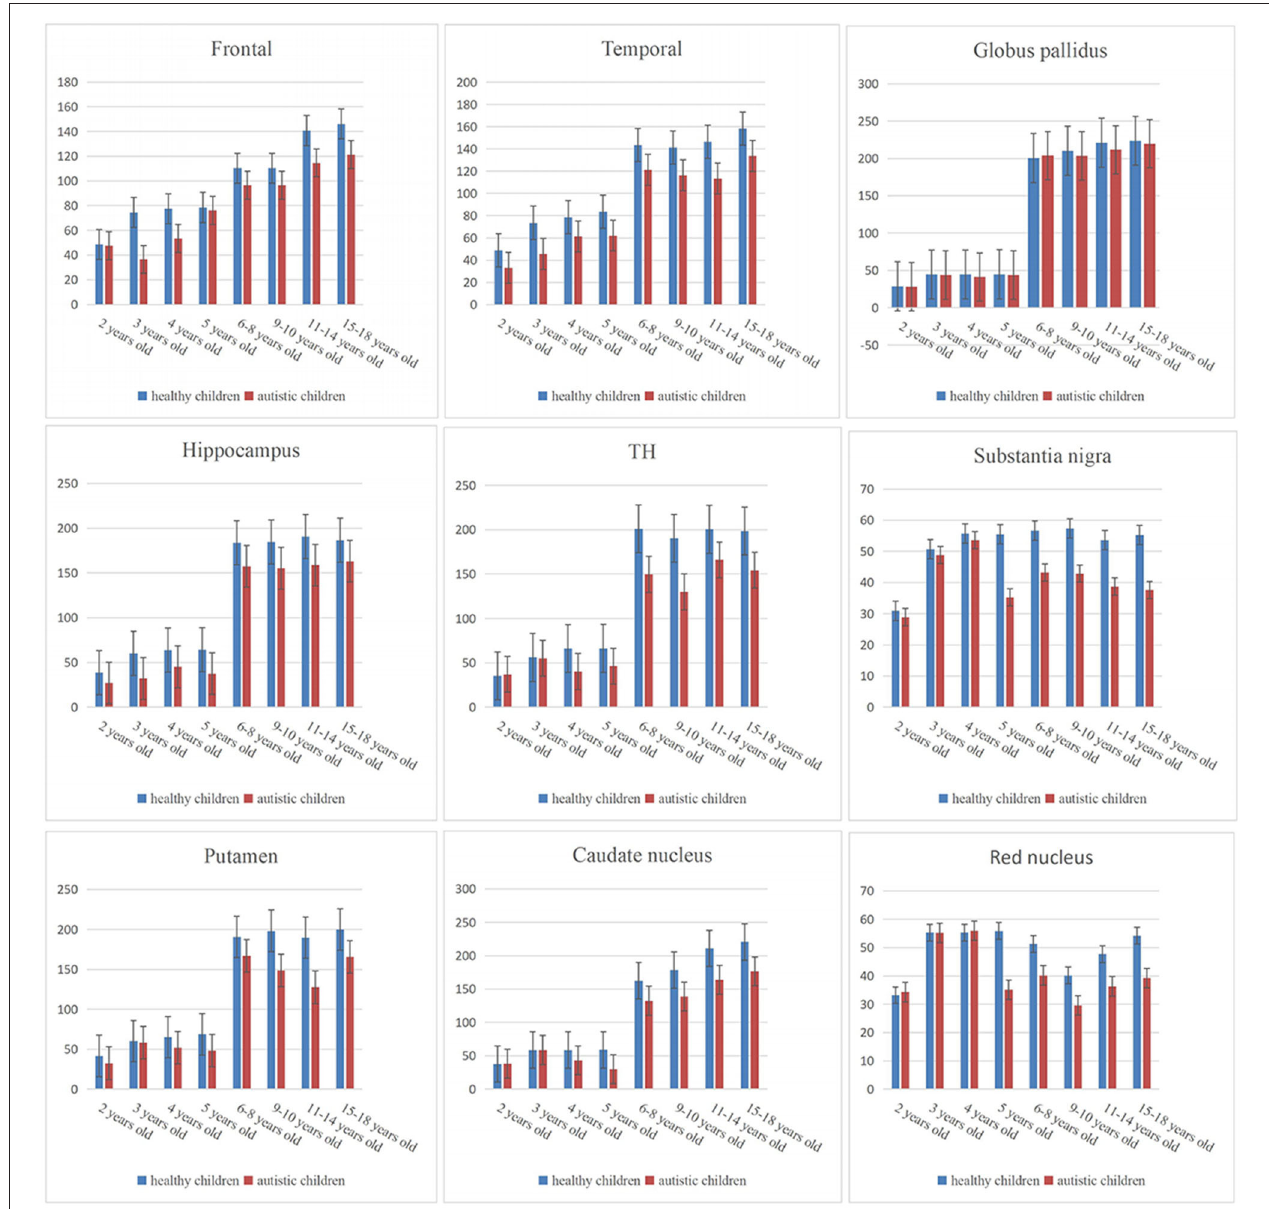
FIGURE 3 | Bar chart of CBF values of brain regions in